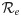
Future risk of ZIKV outbreaks.(A) The evolution of the immunity status per age group in a population of 10,000 agents for the next 80 years based on the demographic structure of Nicaragua. (B) Heat map of the distribution of the attack rates resulting from the reintroduction of ZIKV in the population at each year (1000 simulations for each year). (C) The evolution of the proportion of reintroductions resulting in outbreaks (with a threshold of 1%) with time (green), proportion of susceptible (orange), and effective reproduction number Re (purple).